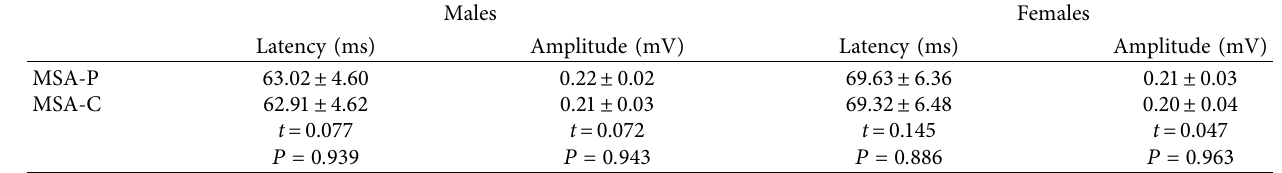
Table 4: Comparison of mean BCR latency and amplitude between the MSA-P and MSA-C groups.